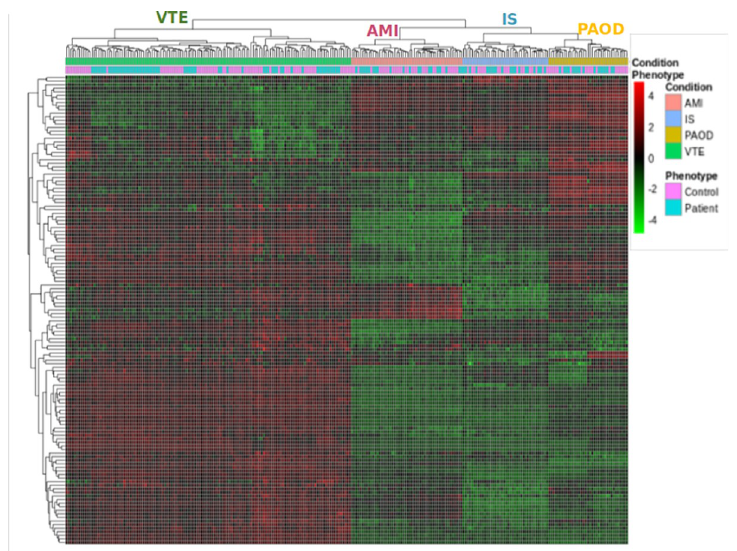
Fig 3. Heatmap built with the 124 DE genes that were divergently expressed between VTE and CVD. Each column represents an individual (control or patient) and conditions are shown in the upper row. Unsupervised clustering of these genes demonstrates that IS. MI and PAOD are clustered together, separately from